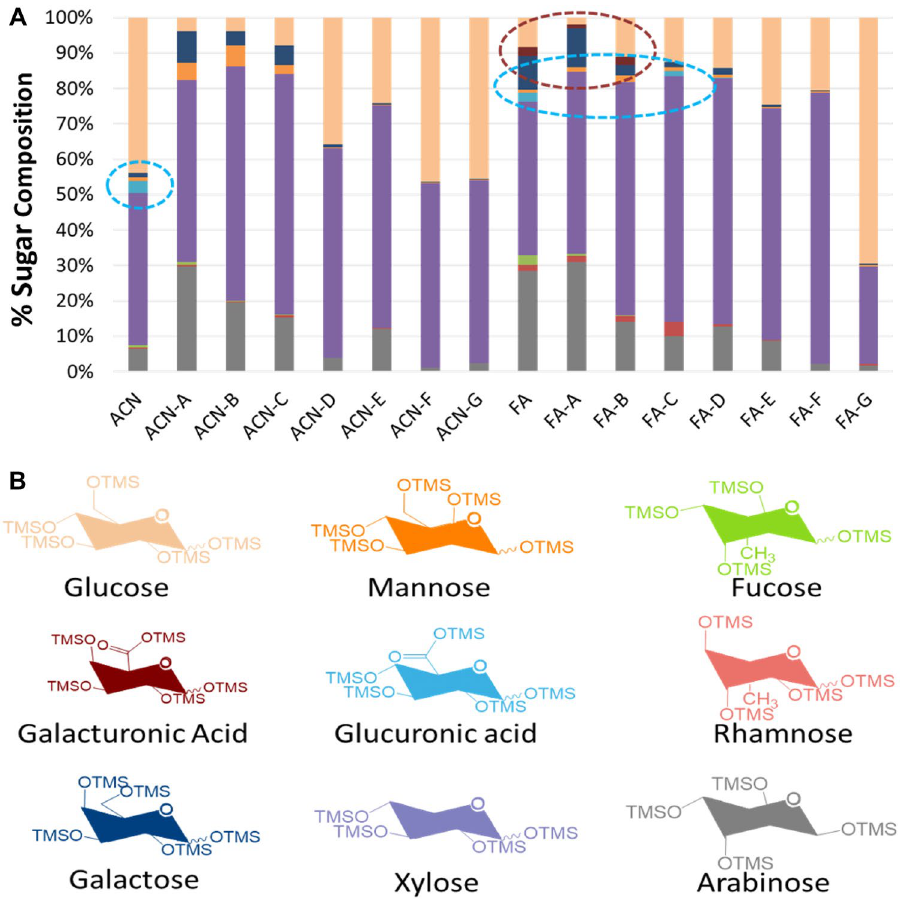
Figure 5. Glycosyl-residue composition analyses of recalcitrant oligosaccharides. Here, ( A ) TMS sugar composition of different oligosaccharides fractions obtained using GC–MS analysis. and ( B ) Structures